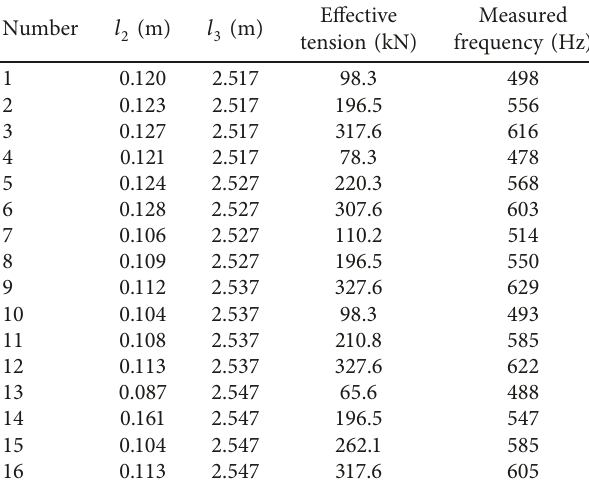
Table 4: The parameters used in and the frequencies measured from the field